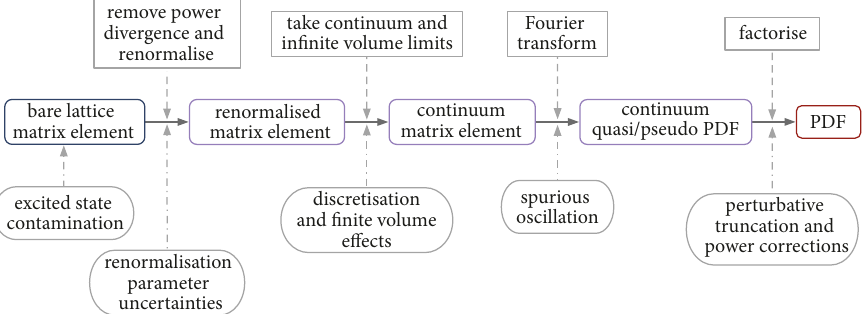
Figure 11: Schematic representation of different steps needed to extract light-cone PDFs from quasi-PDFs and of the challenges encountered at these steps. Source: [51] (arXiv), reprinted with permission by the